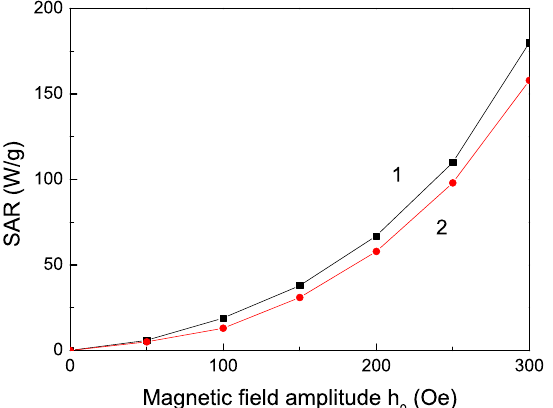
Figure 6. Dependence of SAR on the magnetic field amplitude h 0 of a Fe ( x = 0.1) (1) and Co ( x = 0.12) (2) doped MgO NP, d = 20 nm, for f = 100 kHz and T = 315